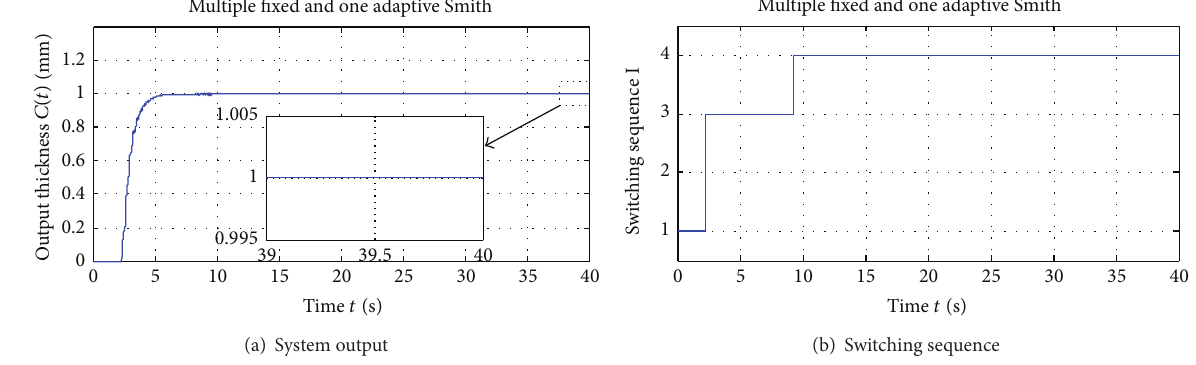
Figure 9: Multiple fixed and single adaptive Smith prediction model.